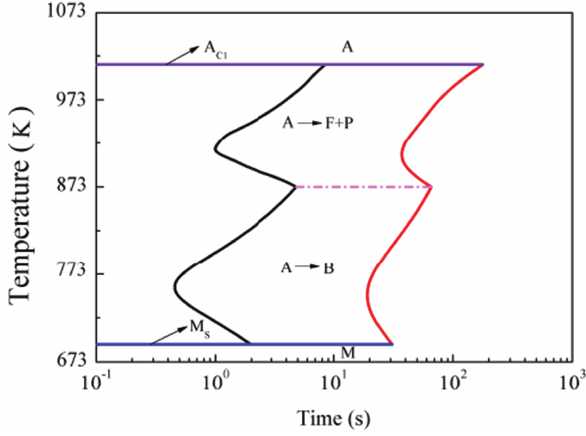
Figure 5: The constructed isothermal transformation curves of